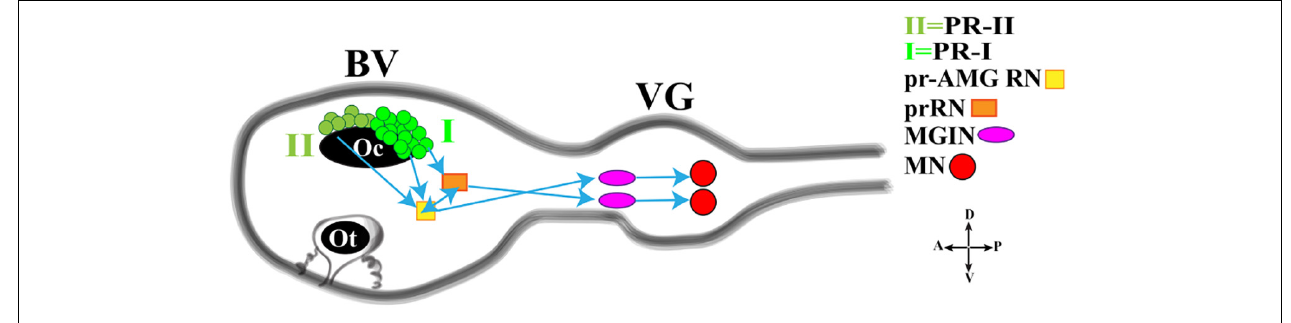
FIGURE 3 | Cartoon of a Ciona tadpole larva Central Nervous System showing the minimal visuomotor circuit. D., dorsal; V., ventral; A., anterior; P., posterior; PR-II, photoreceptor group II; PR-I, photoreceptor group I; pr-AMG RN, Photoreceptor Ascending Motor Ganglion Relay Neuron; prRN, photoreceptor Relay Neuron; MGIN, Motor Ganglion InterNeuron; MN, Motor Neuron. BV, Brain Vesicle; VG, Visceral Ganglion. Adapted from Kourakis et al. (2019).